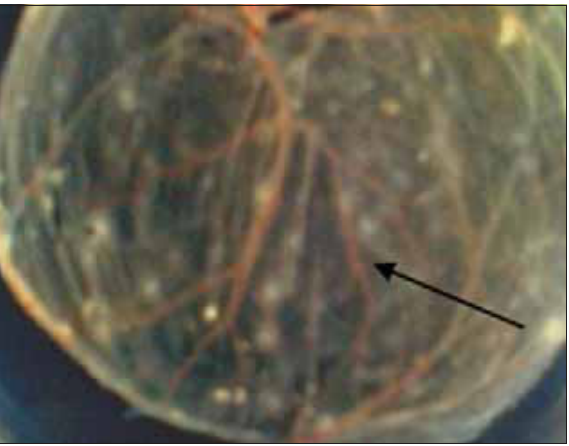
Figure-4: Pocks produced by vaccine strain of fowl pox virus at first passage.